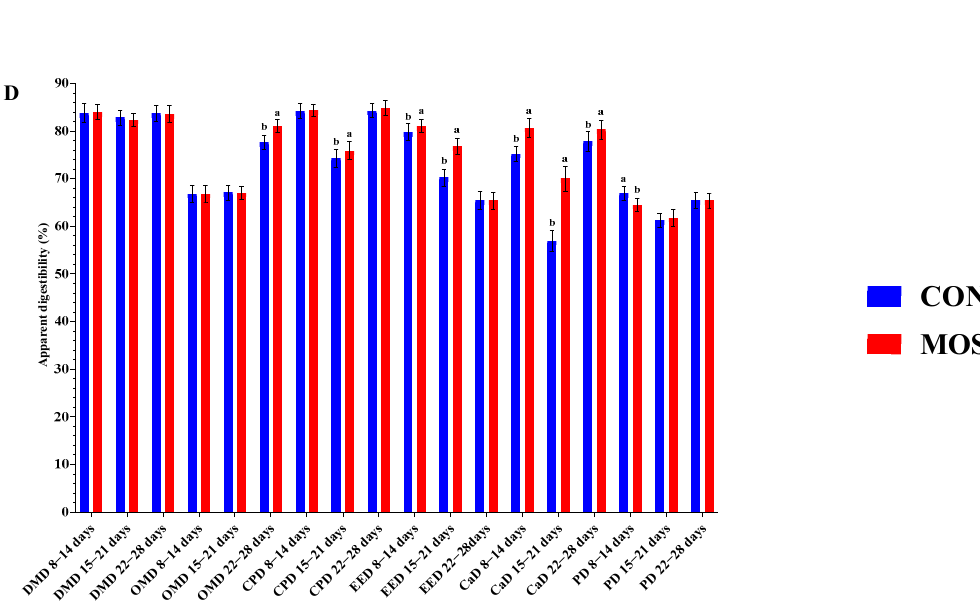
Figure 1. Growth performance of Hu lambs treated with either control or mannan oligosaccharides milk replacer. ( A ) Body weight of Hu lambs at different ages; ( B ) average daily weight gain of